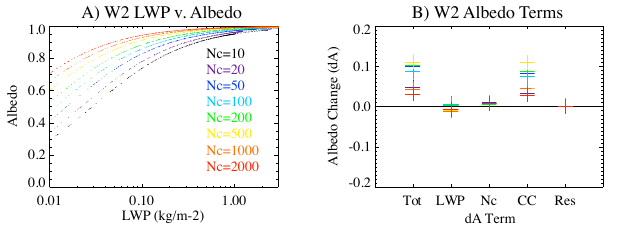
Figure 2. (a) Liquid water path (LWP) vs. albedo and (b) albedo change by different sensitivity (d A ) terms from the oscillating warm rain case (W2). Different colors correspond to different fixed cloud drop number concentrations. The albedo terms in (b) correspond to the total (Tot) change and the portion due to LWP, number concen- tration ( N c ), cloud coverage (CC) and a residual